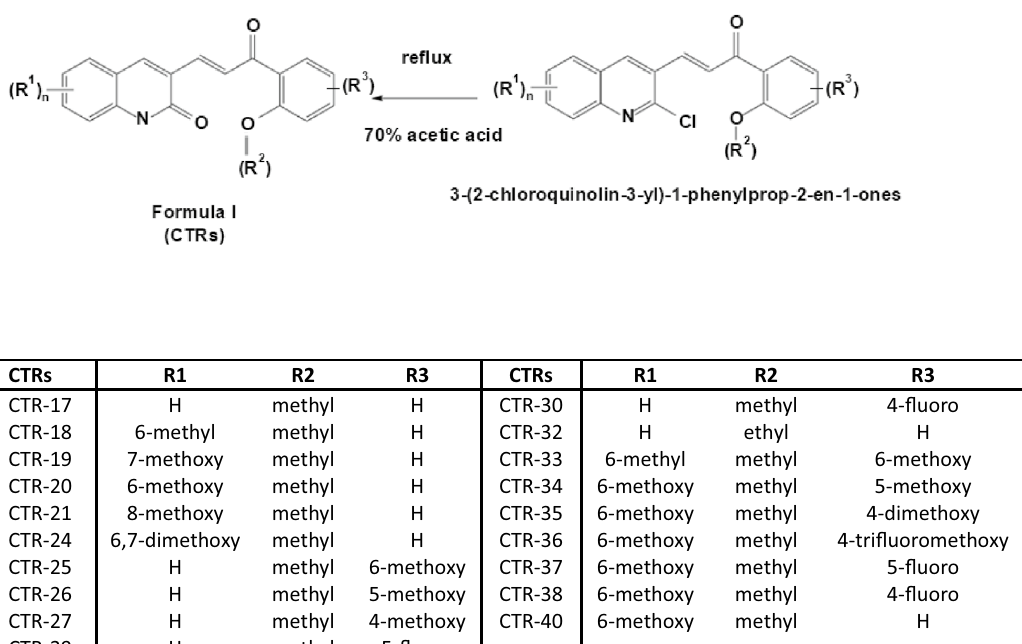
Figure 1. Synthesis Scheme and Structures for quinolone chalcones analogs.